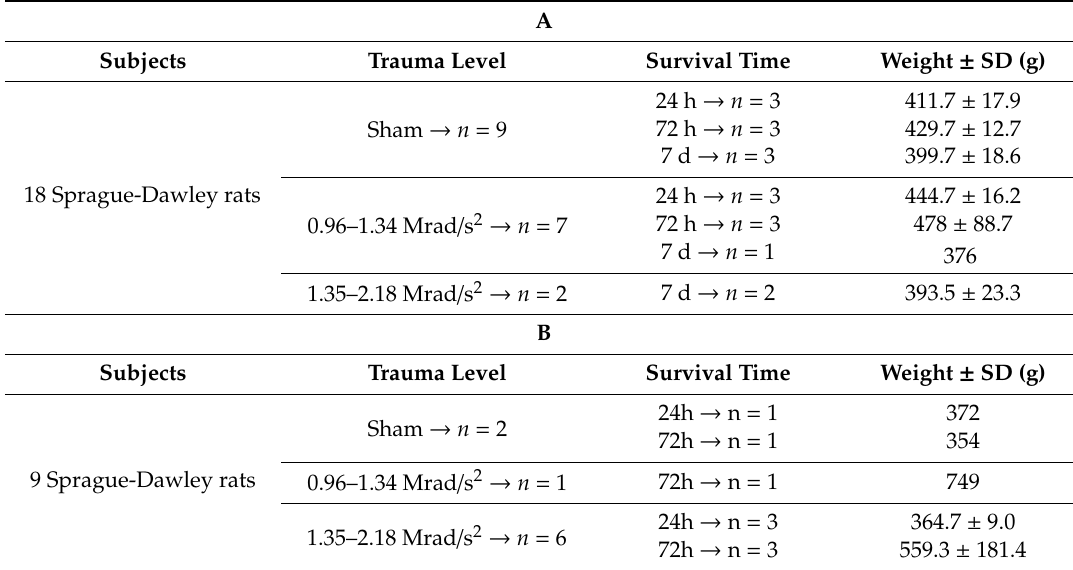
Table 1. Information on the animals included in the study. The table summarizes information about the trauma, angular acceleration, survival time and weight of the animals included in the study. ( A ) refers to subjects who were included in both quantitative and qualitative analysis, while subjects in ( B ) were included only in preliminary qualitative